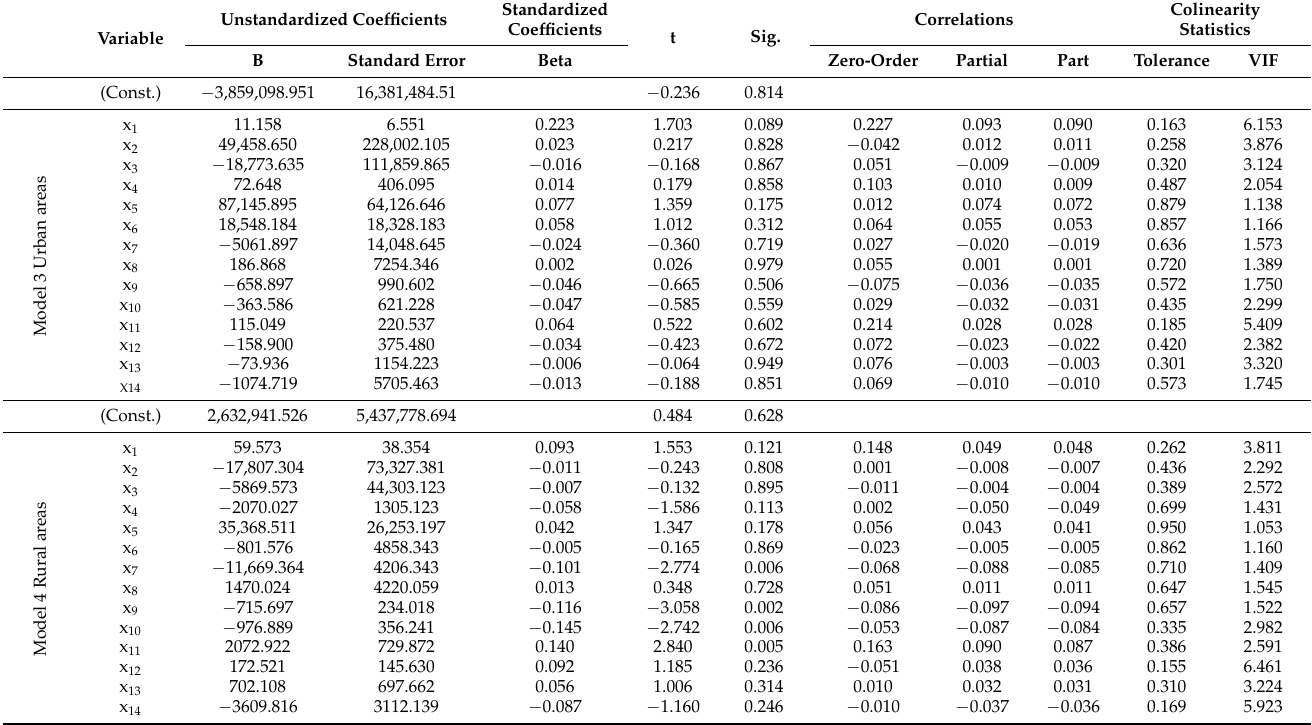
Table 9. Model 1 and model 2 coefficients a,b